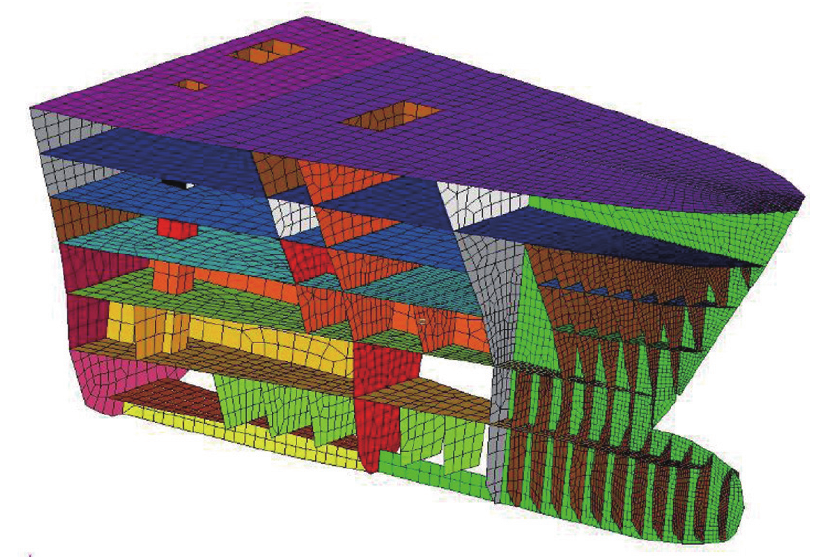
Fig. 7. Finite element model of bow of the container vessel used in the analyses.